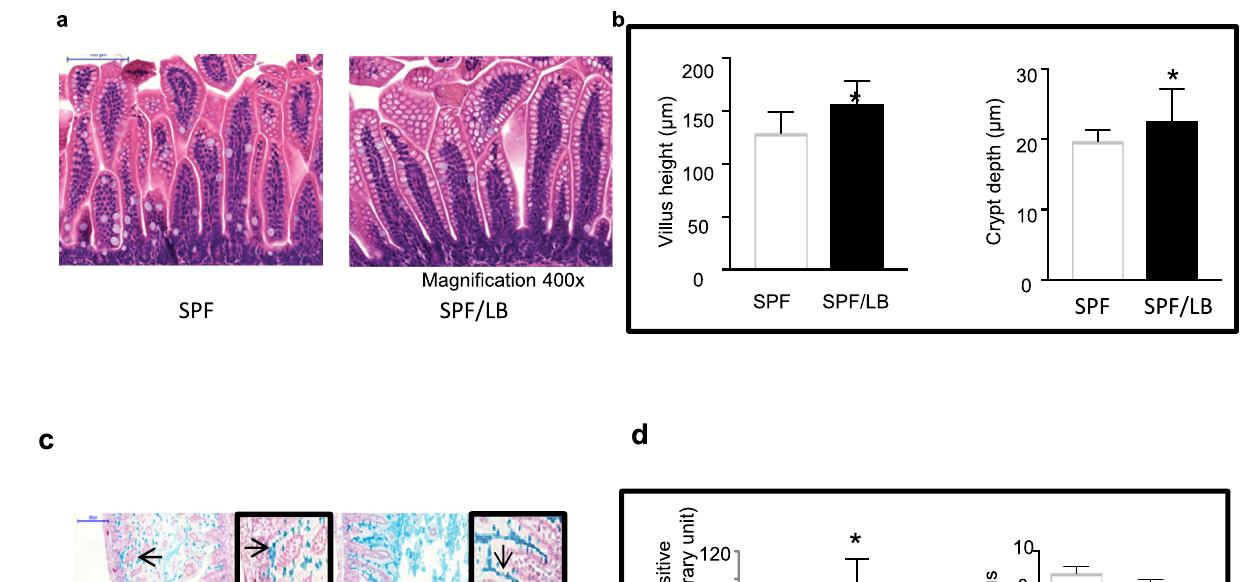
PLOS ONE | https://doi.org/10.1371/journal.pone.0237182 August 7,